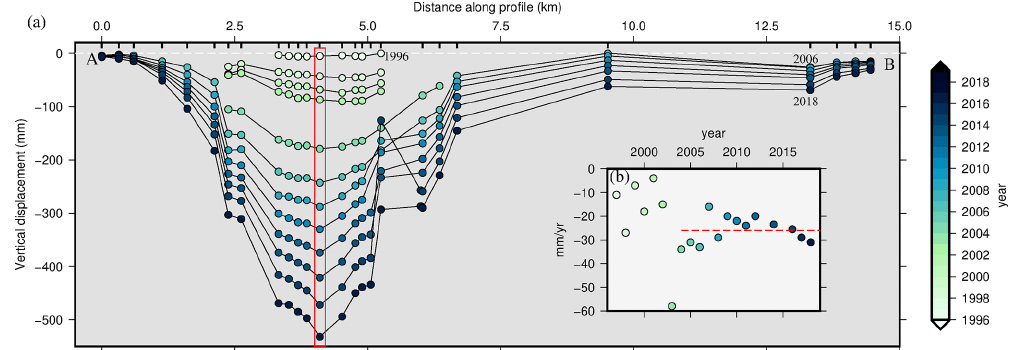
Figure 3. (a) Leveling data along the A–B profile (red line in Fig. 2b) performed by IGN from 1996 to 2018 (color scale). Data are displayed every 2 years for ease of reading. (b) Deformation velocity associated with the marker with the largest subsidence (red rectangle in a ). The velocity is given for each year, using the same color scale as in (a) . The red dashed line represents the mean velocity of vertical displacement observed from 2004 to 2018.